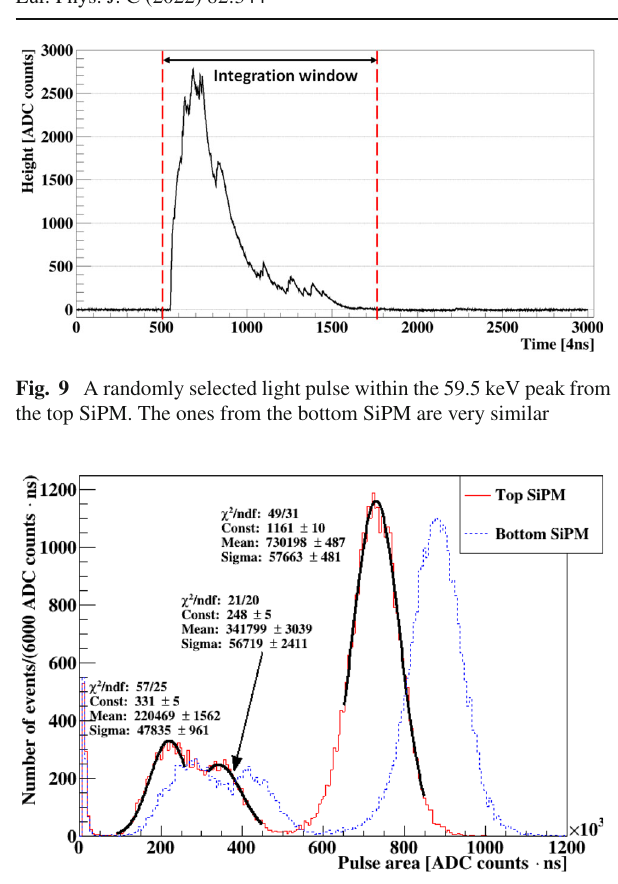
Fig. 10 Energy spectrum of 241 Am as the distribution of pulse areas in units of ADC counts ·